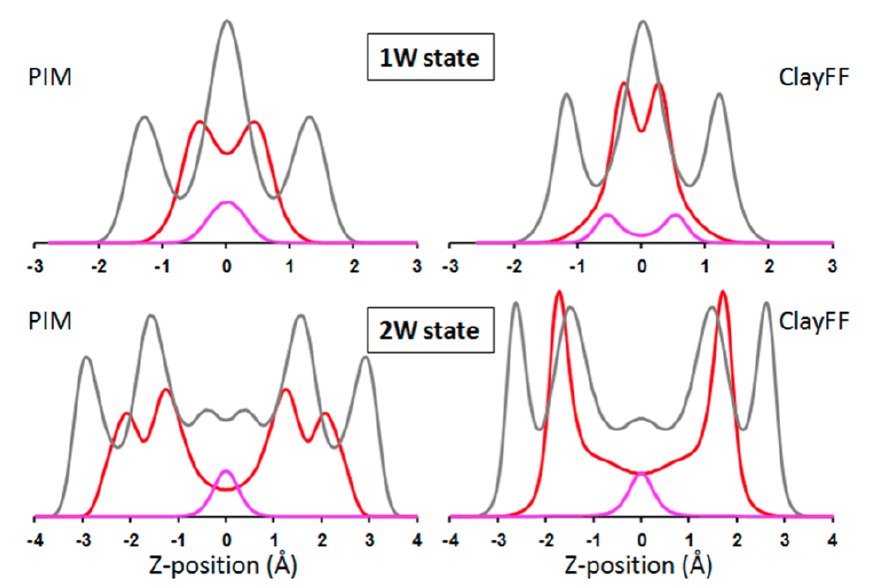
Figure 3. Atomic density profiles (arbitrary units) of oxygen (red), hydrogen (gray), and sodium (pink) atoms generated from MD simulations using PIM (left) or ClayFF (right) models for monohydrated (1W-top) and bihydrated (2W-bottom) hydration states. Atomic Z coordinates (in Å) are given relative to the mid-plane of the